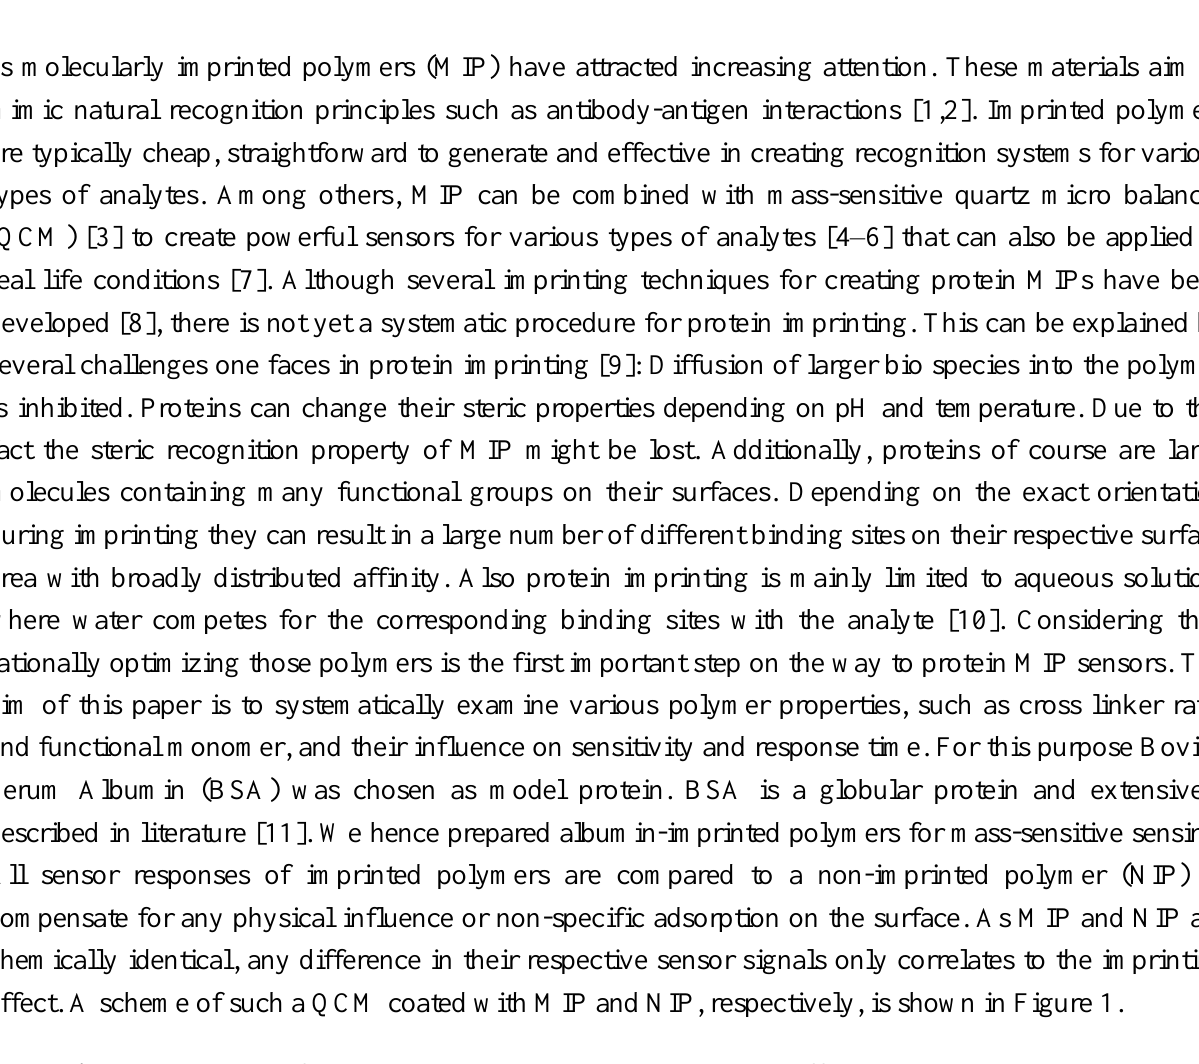
Figure 1. Scheme of a two-electrode quartz coated with two different polymers; molecularly imprinted polymer (MIP) and non-imprinted polymer